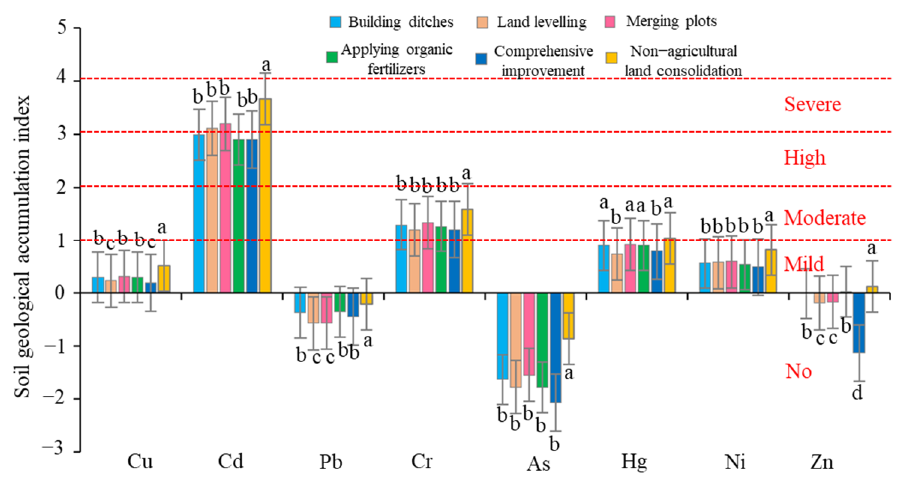
Figure 12. Evaluation results of soil geoaccumulation index in the study area. Note: Different lowercase letters represent significant differences at the p < 0.05 level.